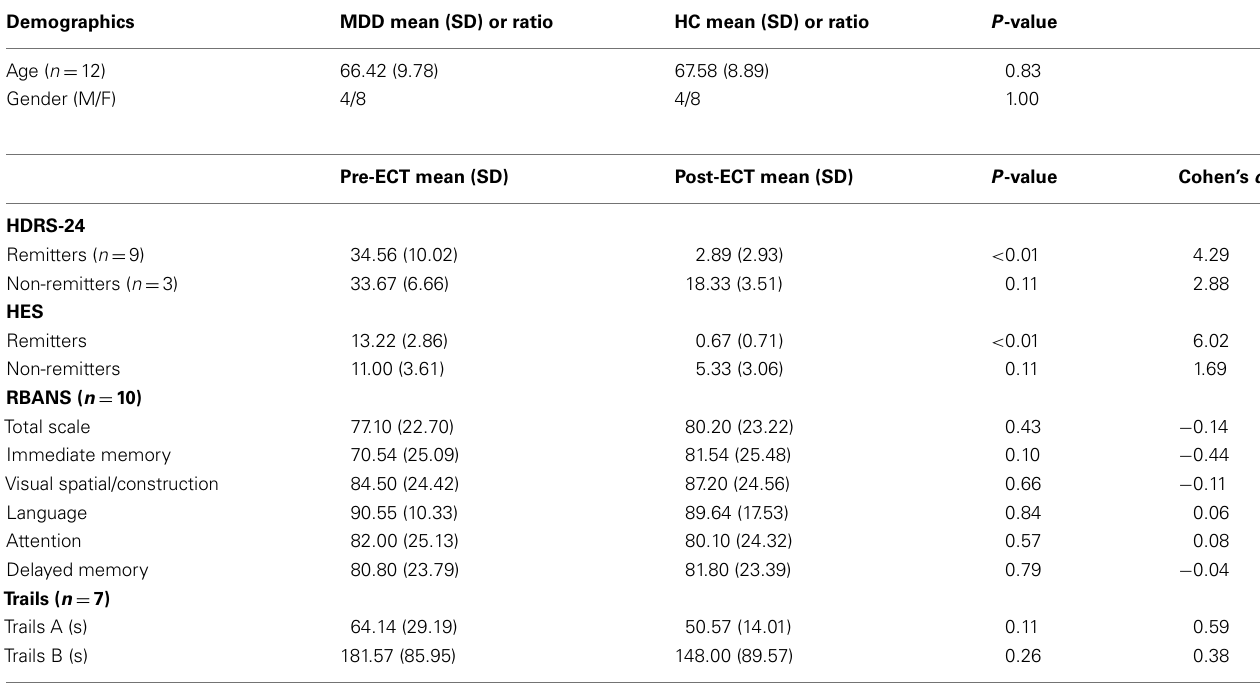
Table 1 |The top section includes the demographic variables of the subjects with major depressive disorder (MDD) and demographically matched healthy comparison subjects (HC). The lower section includes clinical symptom ratings and neuropsychological indices (RBANS index scores, Trail MakingTest Parts A and B in seconds).